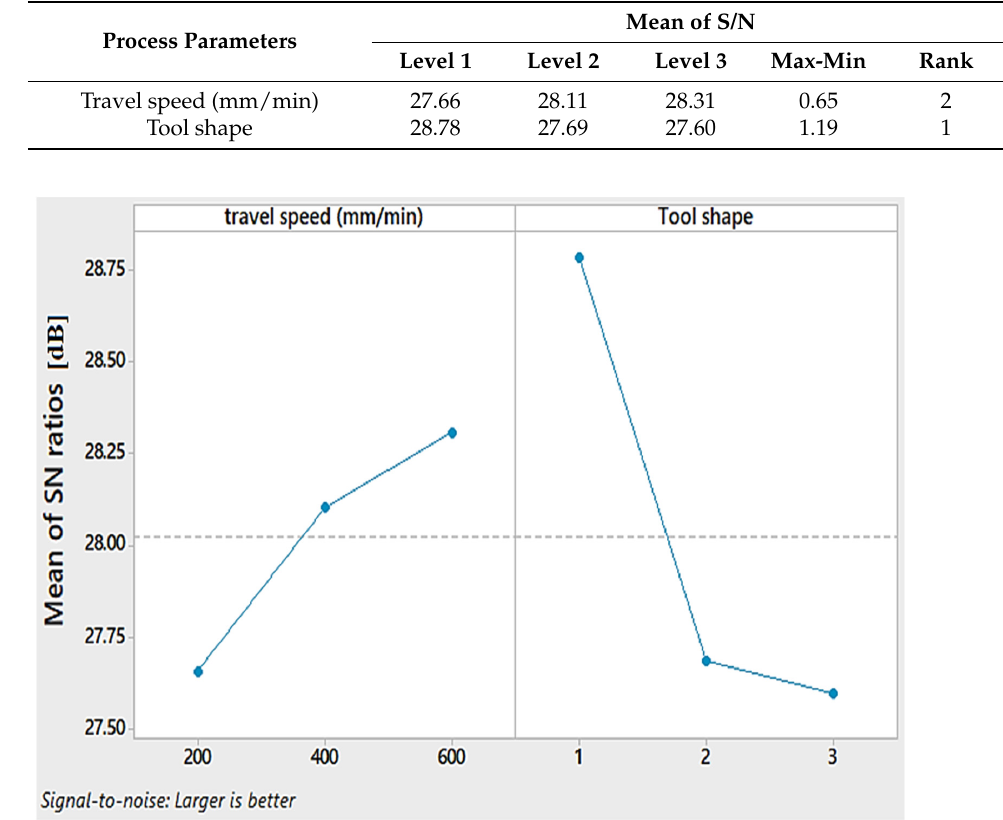
Table 7. Mean S/N ratio response table for hardness.